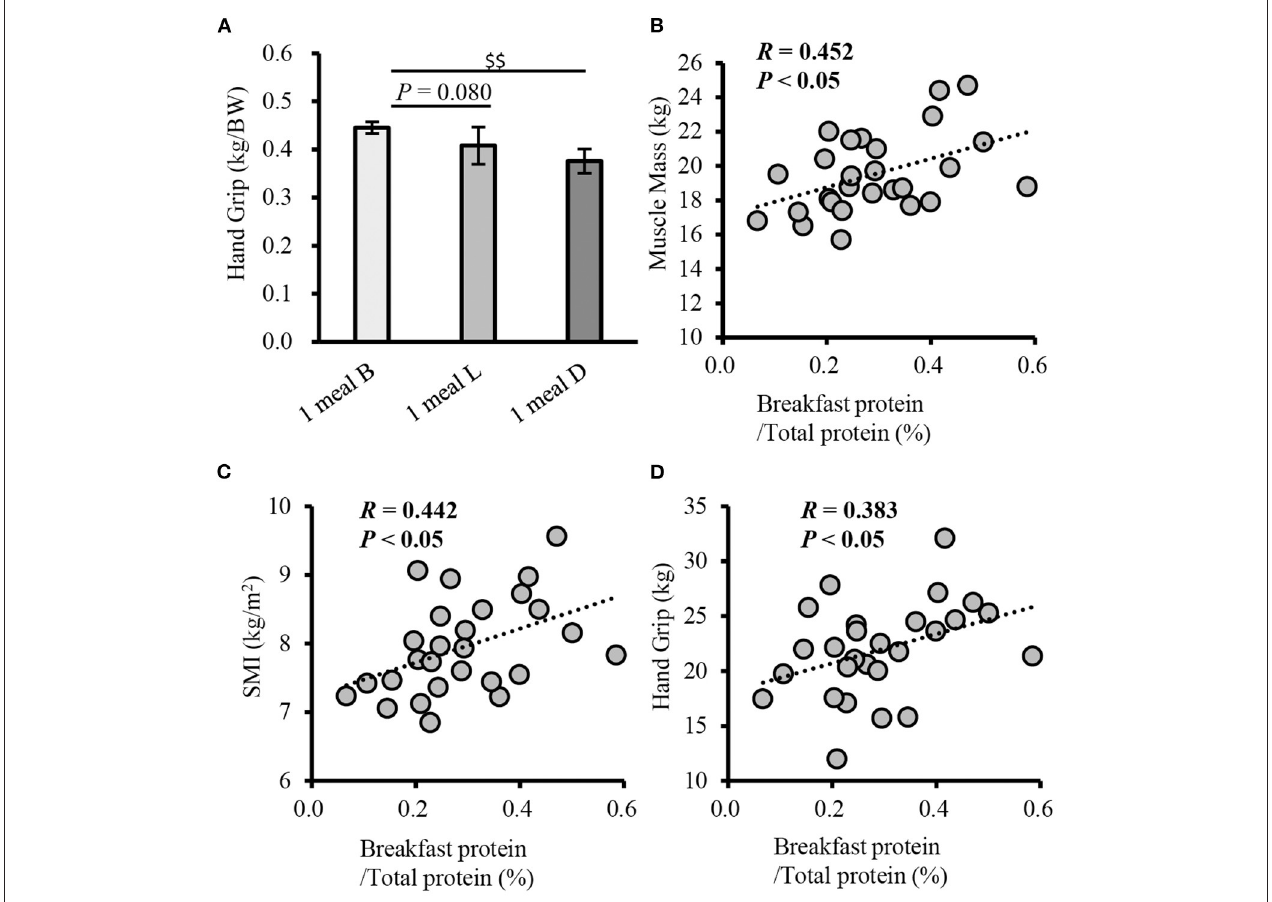
FIGURE 5 | Comparison of handgrip strength between patterns with only one meal of adequate protein intake, and correlation of the rate of breakfast protein intake with physical function (cross-sectional study 2-3). (A) Comparison of grip strength between patterns with only one meal of adequate protein intake, Correlation between muscle mass (B) , SMI (C) , handgrip strength (D) , and the rate of breakfast protein intake. Values are expressed as mean and standard error. $$ P < 0.01, compared to 1 meal D (one-way ANOVA). Pearson’s product-moment correlation coefficient. SMI, skeletal muscle index; B, breakfast; L, lunch; D,